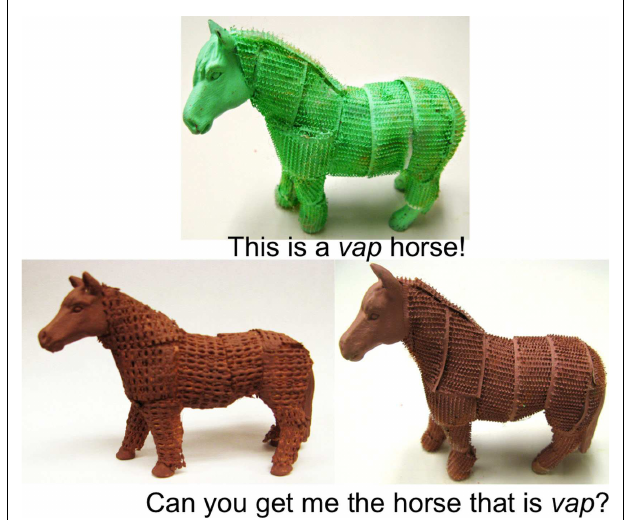
FIGURE 9 |The novel adjective learning task used in the study by Yoshida et al. (2011).